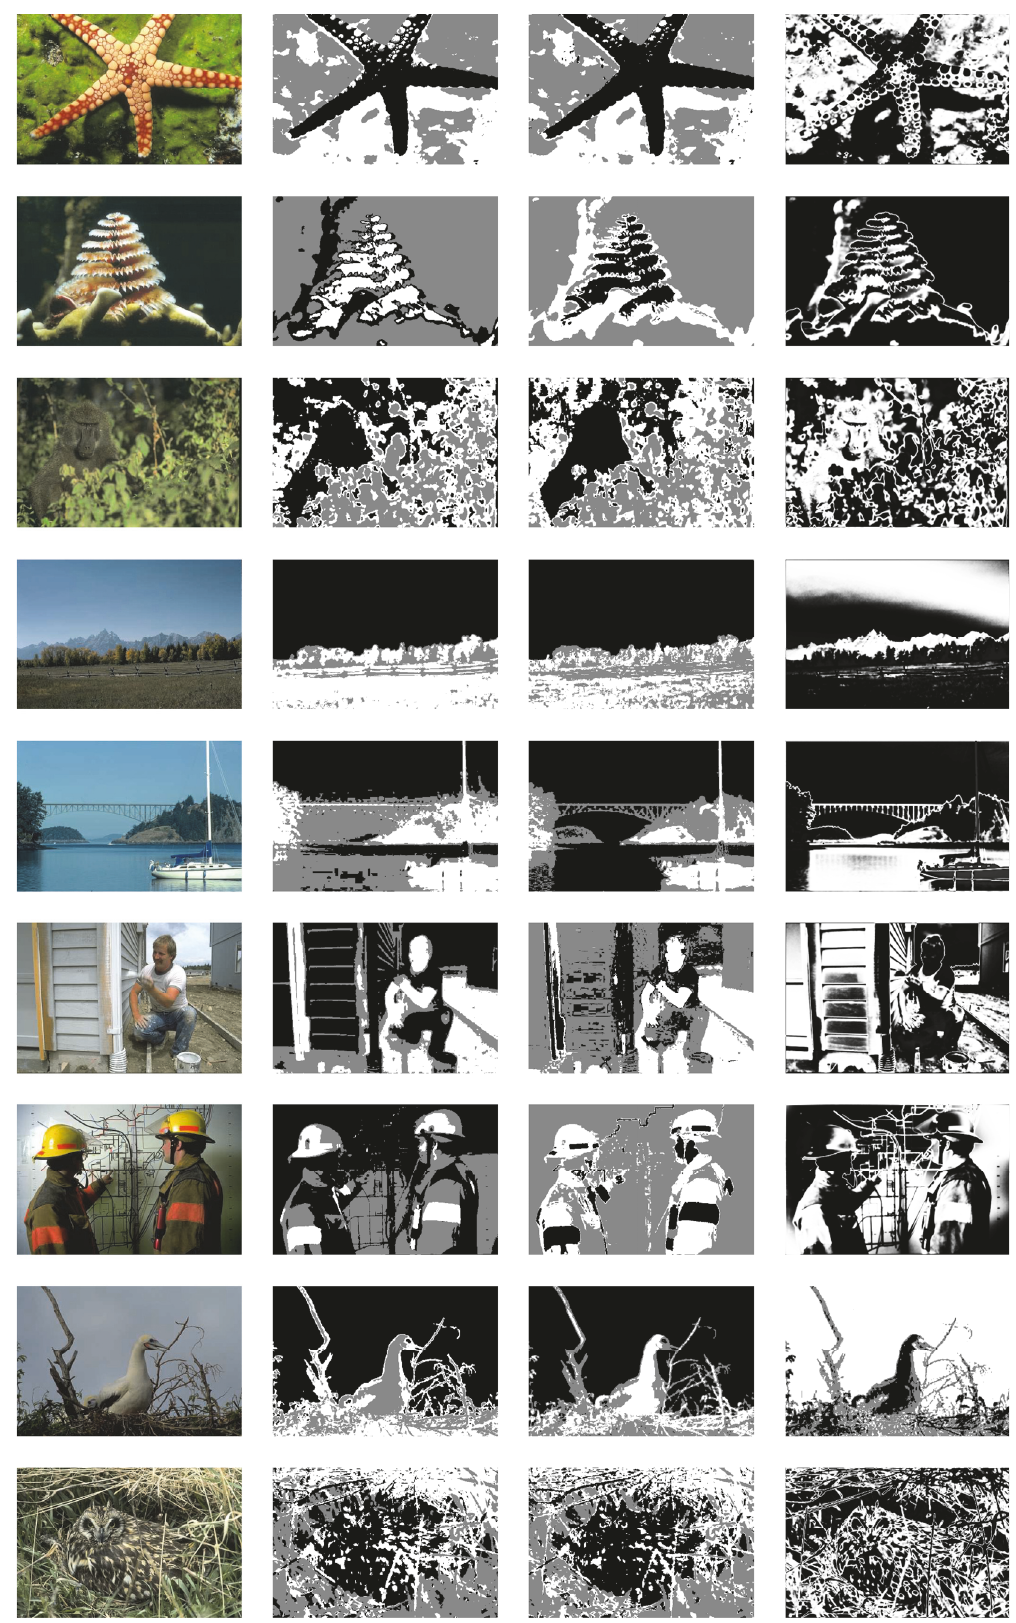
Figure 2: Original image, grayscale image using FCM, GK, and FCRM are listed,